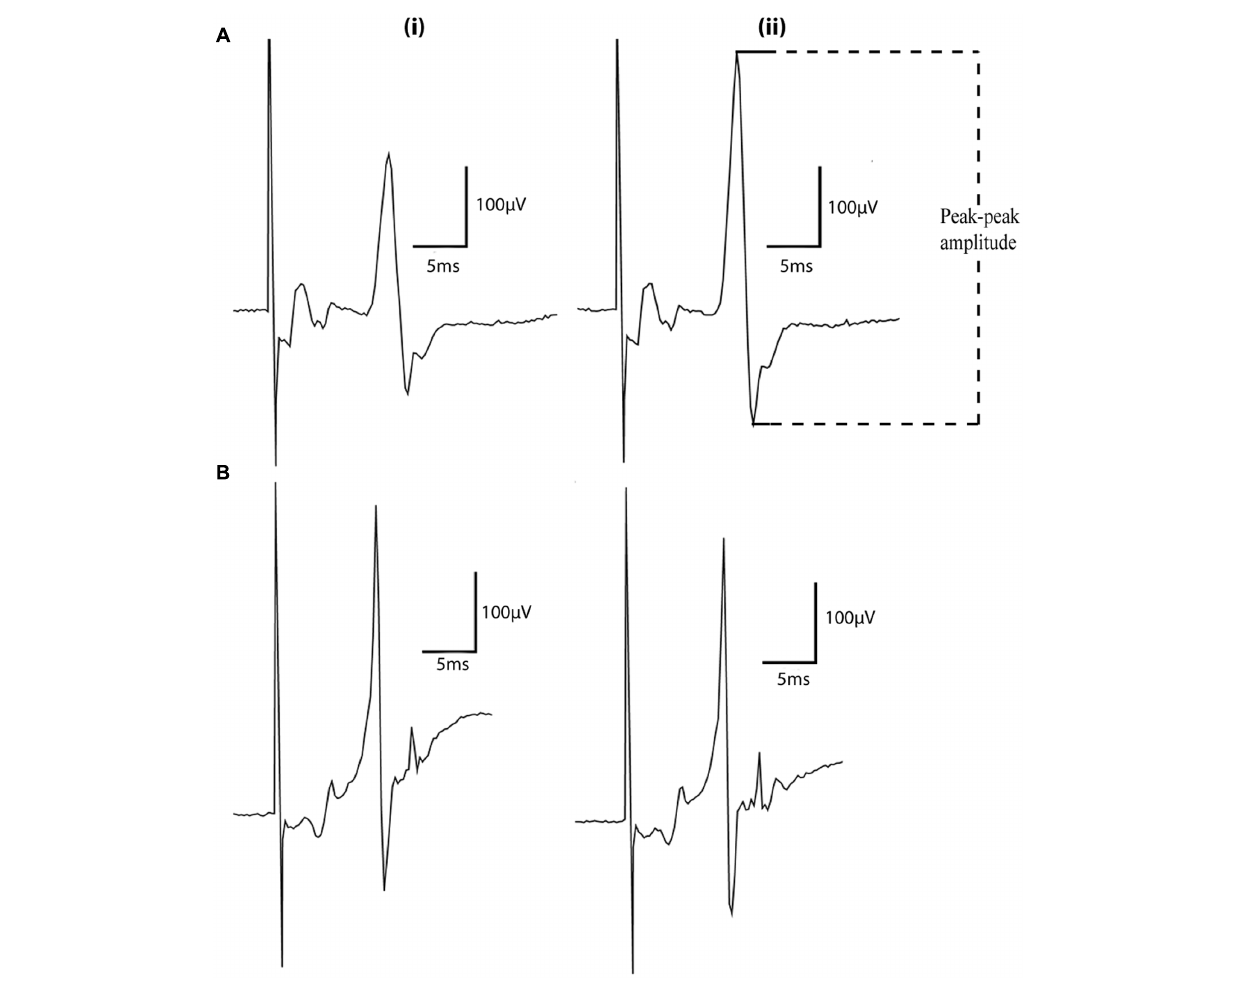
FIGURE 1 | Representative motor evoked potentials (MEP) traces recorded in animals anesthetized with (A) xylazine/zoletil or (B) urethane before (i) and after (ii) intermittent theta burst stimulation (iTBS). Traces shown are an average of 12 sweeps. The dashed lines indicate points used for peak-to-peak measurement of MEP